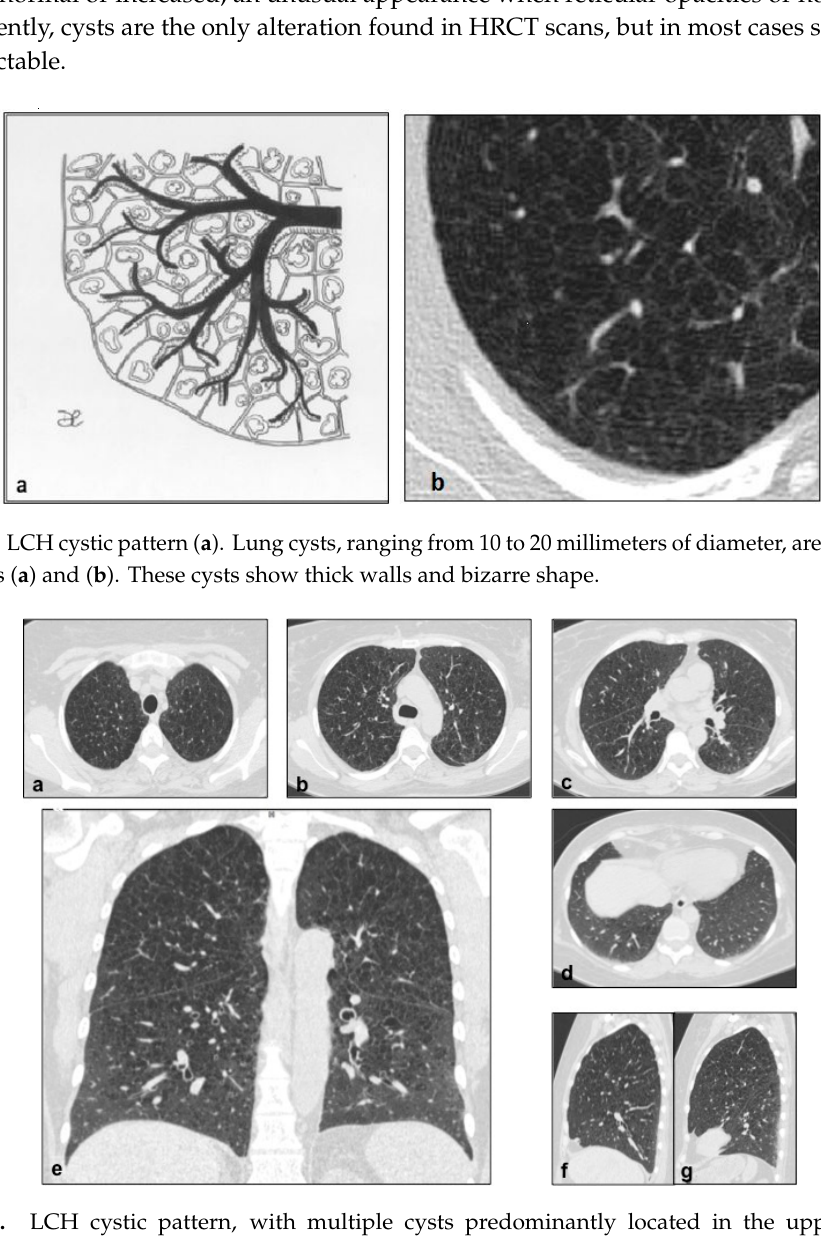
Figure 1. In LCH, cysts may origin from the cavitation of nodules ( a , b ) and can be isolated or confluent, and are mainly located in the middle and superior lobes, with typical sparing of